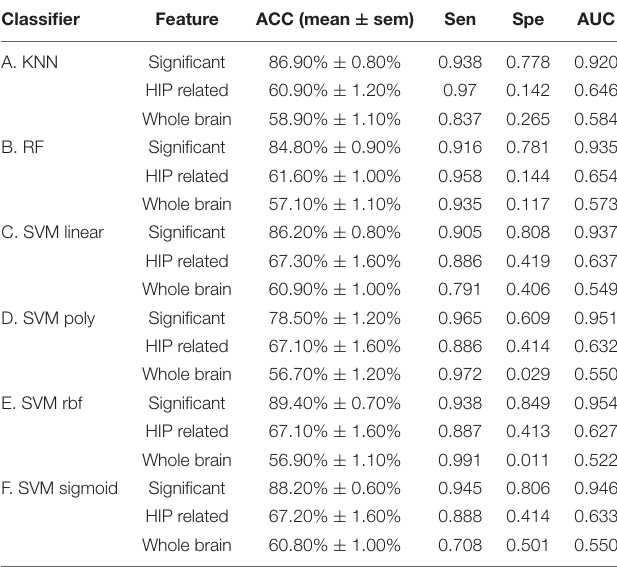
TABLE 2 | Classification performance based on mean diffusivity (MD) feature sets.